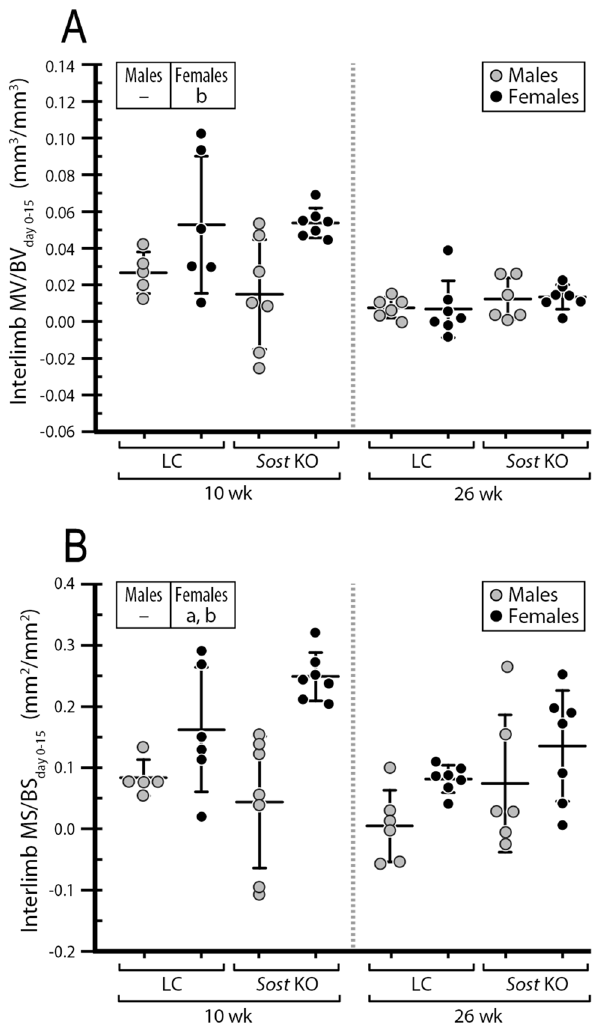
bone surface (BS) at day 0. Data is shown as interlimb difference (loaded-control limb) comparing male with previously published data for female mice 10 . ANOVA: indicates an effect of (a) genotype, (b) age, (c) genotype & age, which was performed separately for each sex. Sample size: 10-week-old LC (male = 5, female = 6), 10-week- old Sost KO (male = 7, female = 7), 26-week-old LC (male = 6, female = 7), 26-week-old Sost KO (male = 6, female =